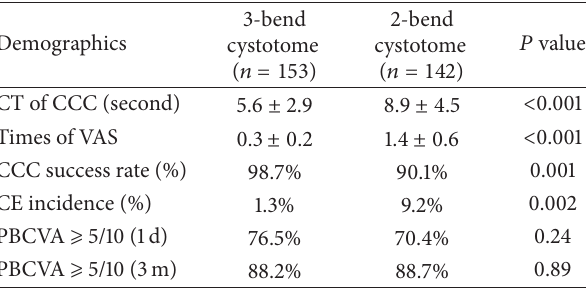
Table 2: Characteristics of eyes in the 3-bend and 2-bend groups during and after